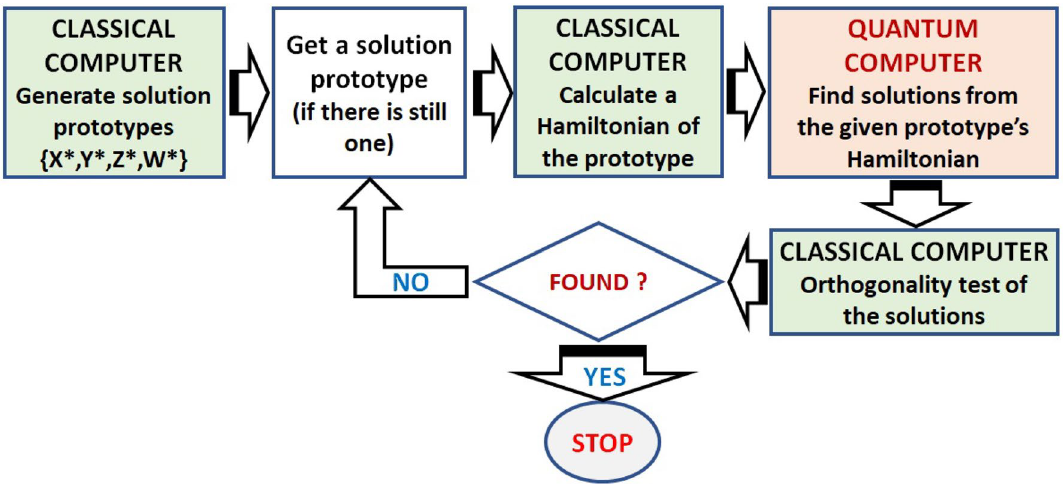
Figure 4. Block diagram of classical and quantum processing in extended Turyn-based quantum computing method. The classical processing includes generation of the { X ∗ , Y ∗ , Z ∗ , W ∗ } solution prototypes, construction of the Hamiltonian, and orthogonality test of the solutions. The quantum computing is solely employed to find the solution (ground state) of the problem defined in the Hamiltonian. In this scheme, the classical and quantum processing will be terminated either after a valid solution is found or we run out of the solution